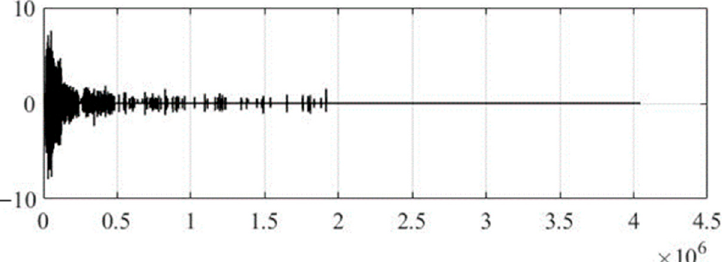
Figure 8. Wavelet coefficients of compressed steganocoded audio signal by six times with full integrity of text information (existing method).